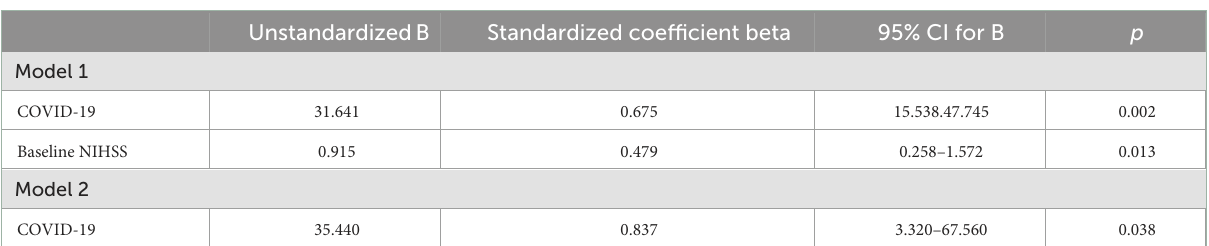
TABLE 2 Multivariate analysis for infarct